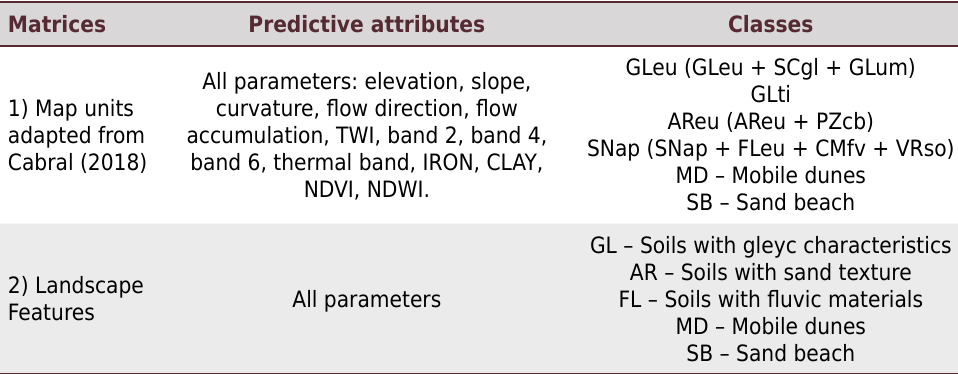
Table 1. Description of data matrices created for DSM Matrices Predictive attributes Classes